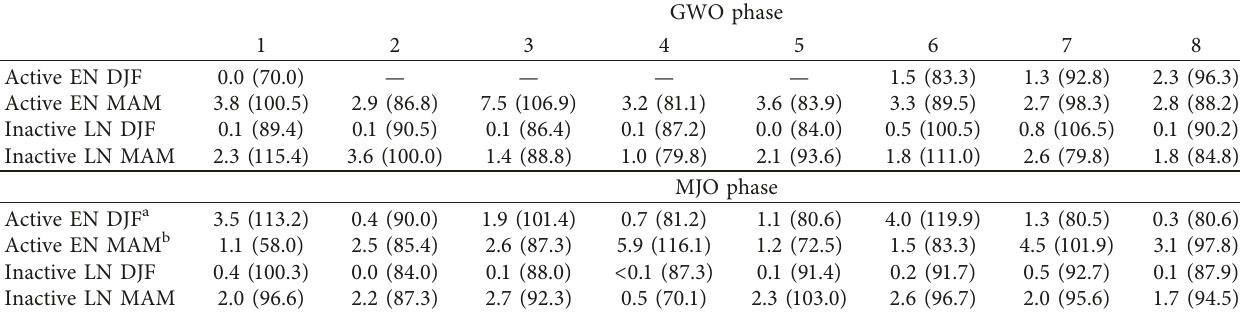
Table 2: Mean (mean rank) of daily tornado count by GWO and MJO